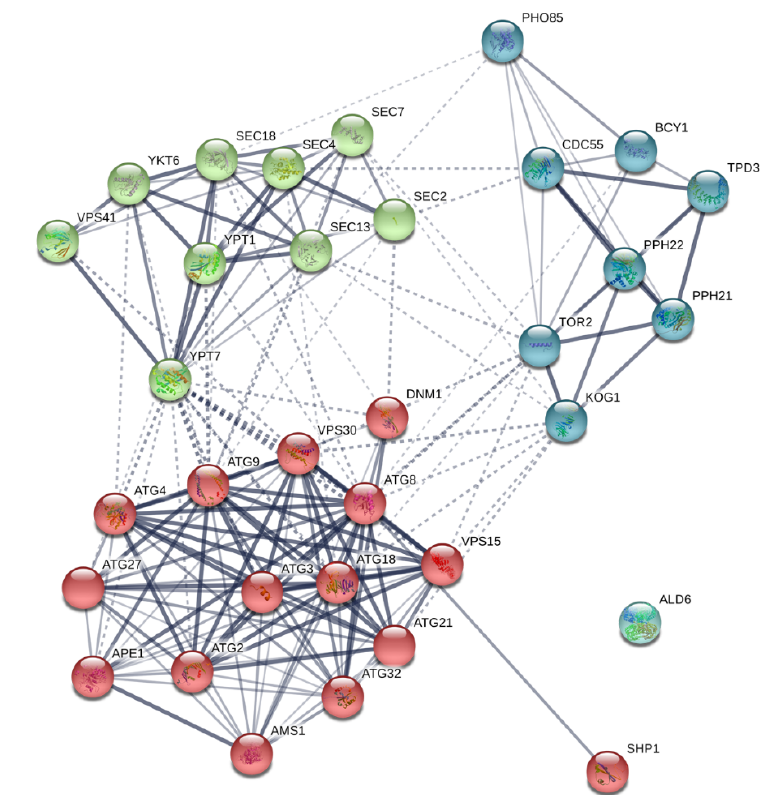
Figure 3. Interaction network map built using STRING v11.0 and based on the 33 autophagy-related proteins in total detected in S. cerevisiae P29 and G1. Proteins are showed as nodes and the existence of interactions between them are represented by lines (connection between nodes). Line thickness indicates the strength of the different interactions. Nodes with the same color represent specific clusters: autophagy regulation and induction (blue nodes), autophagosome formation and vesicle transport (red nodes), and vesicle and vacuole fusion (green nodes). PPI enrichment p -value < 1 × 10 − 16 .